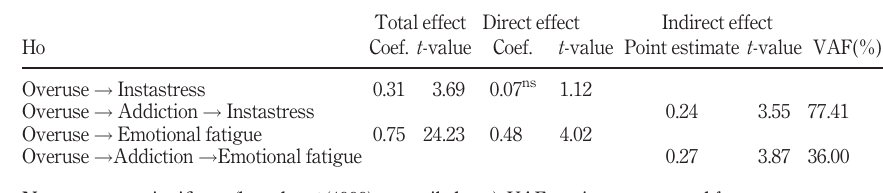
Table IV. Mediating effect